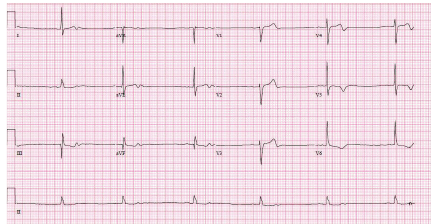
Figure 1: EKG showing sinus bradycardia with nonspecific ST-T wave abnormalities.